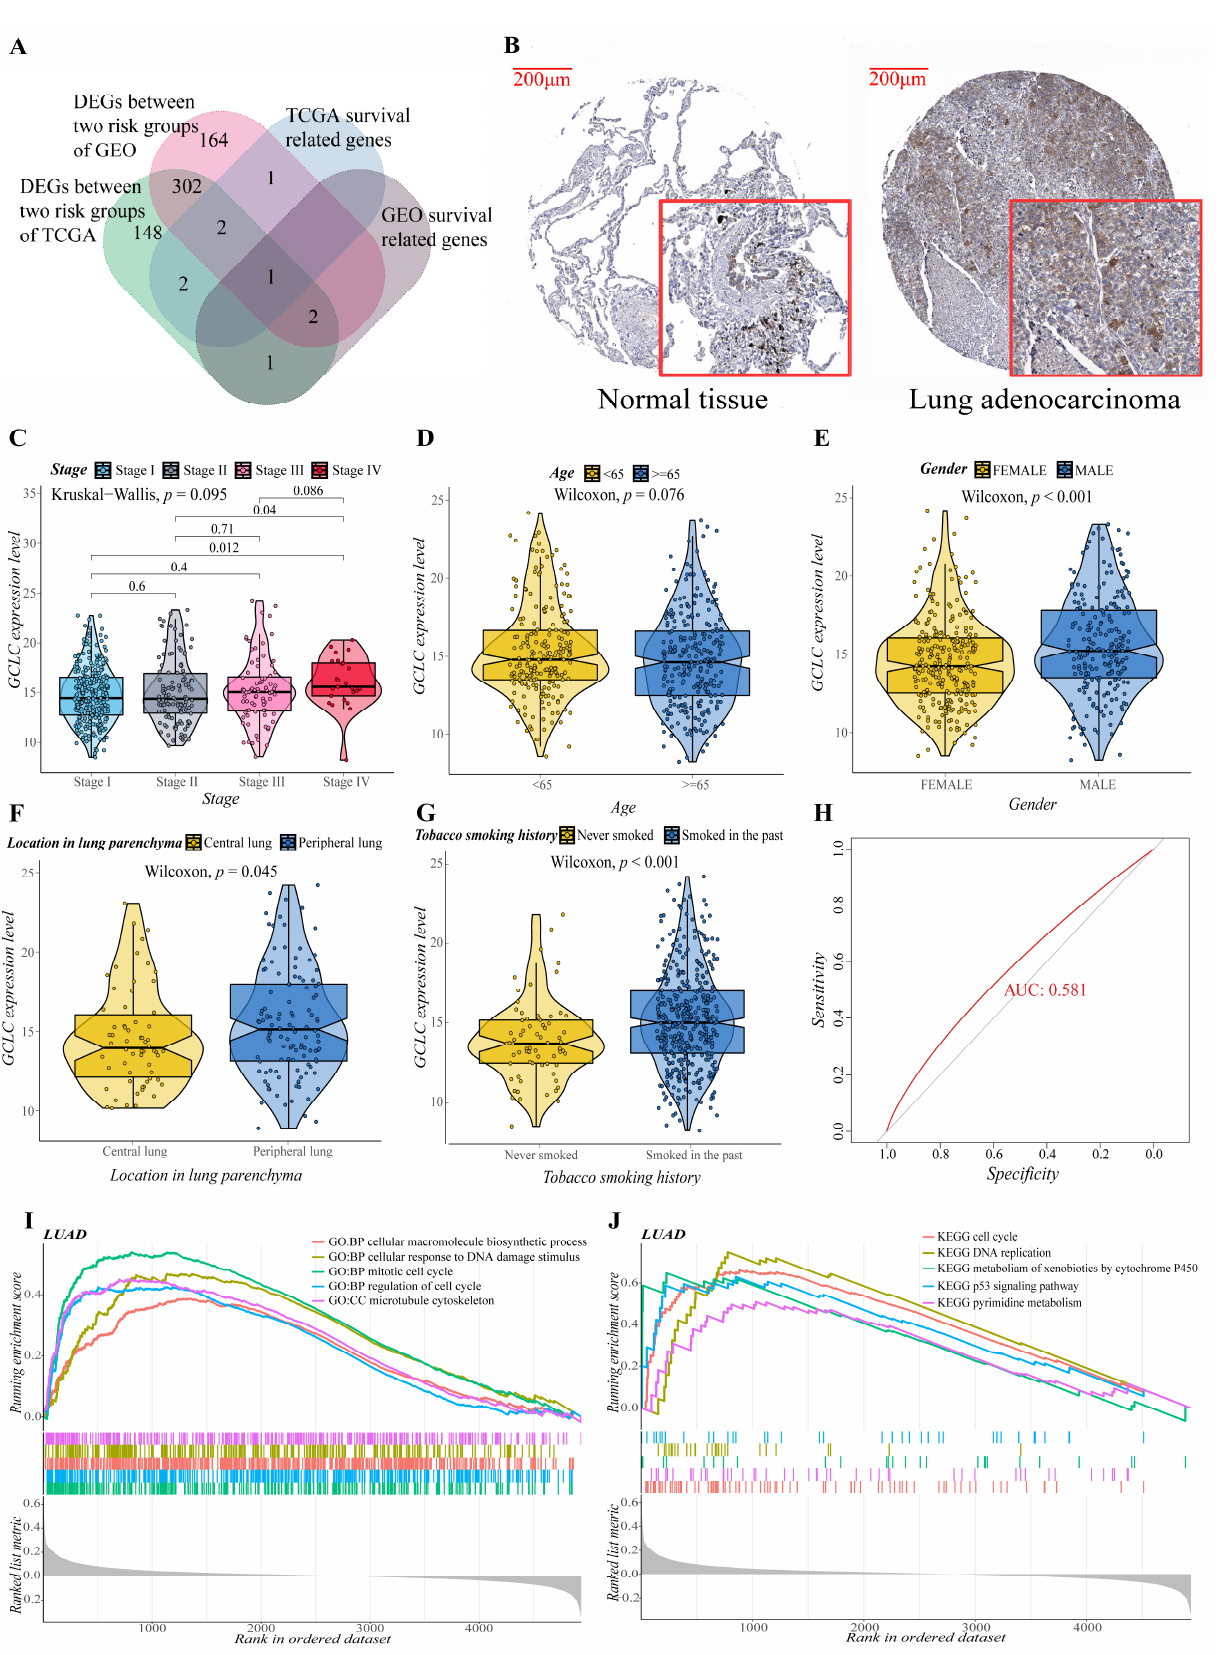
Figure 7. Evaluation of the prognostic value and predictive potential of GCLC. ( A ) Venn diagram of four groups of genes (green: DEGs between two risk groups of training cohort; red: DEGs